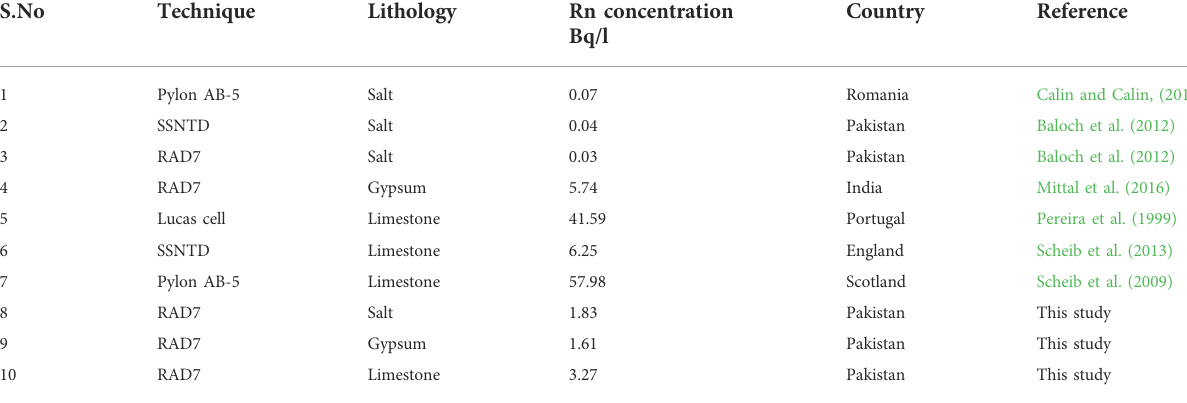
TABLE 1 Comparison of radon concentrations in salt, gypsum, and limestone under investigation with those in other countries. S.No Technique Lithology Rn concentration